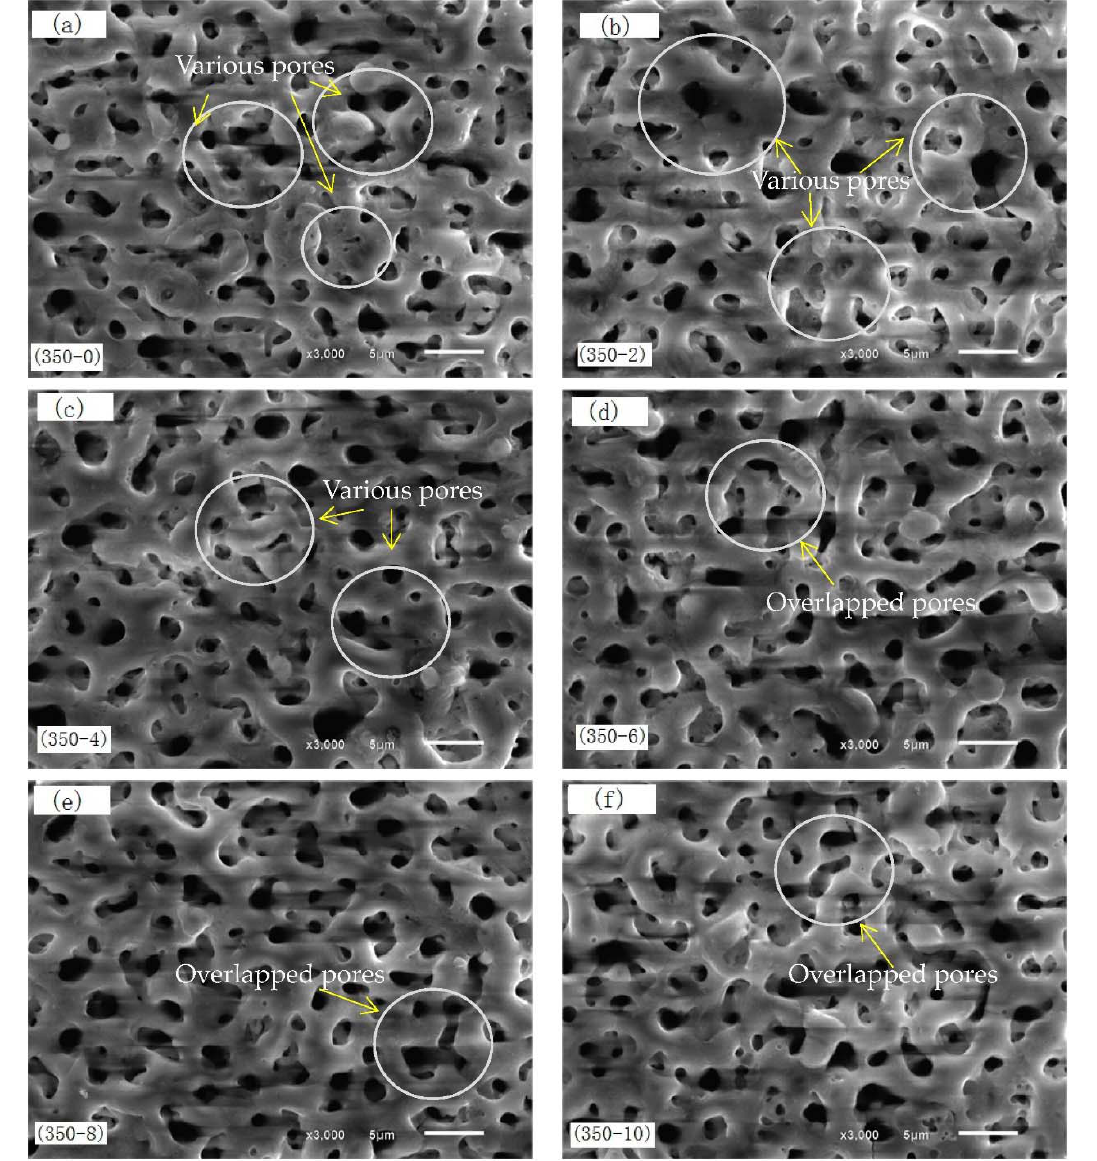
Figure 1. Surface morphology of micro-arc oxidation (MAO) coatings formed at pretreatment with different concentrations of Nd(NO 3 ) 3 solution: ( a ) 350–0, ( b ) 350–2, ( c ) 350–4, ( d ) 350–6, ( e ) 350–8, and ( f ) 350–10.